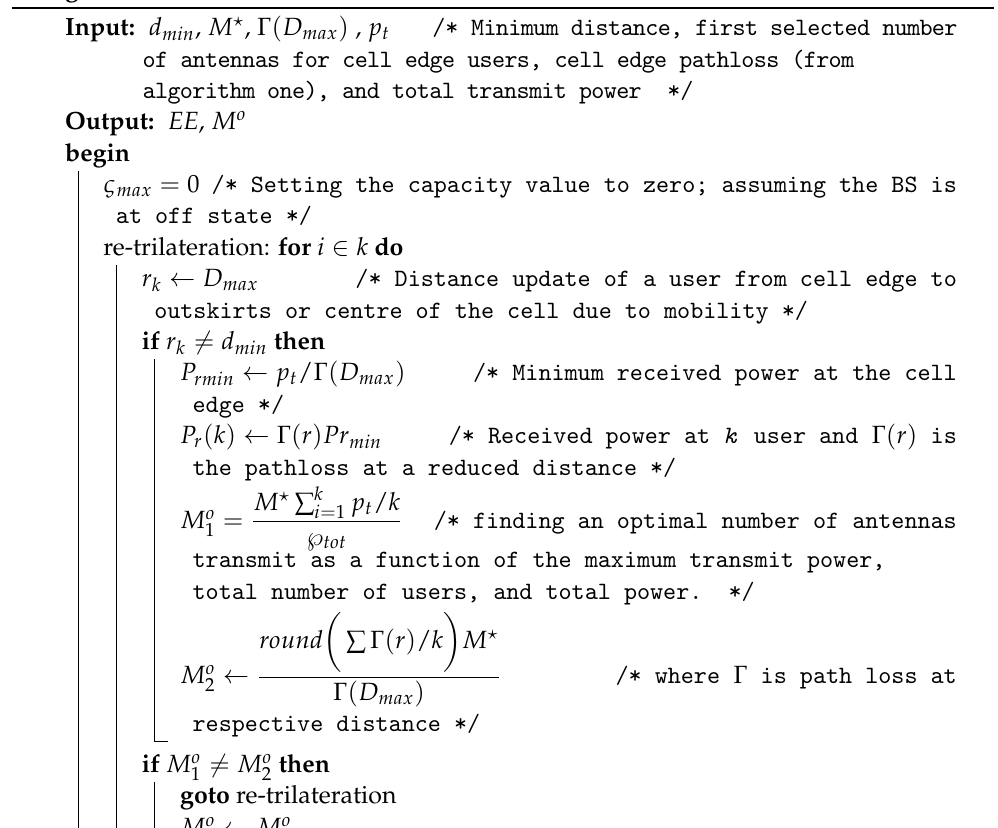
Algorithm 2: Number and element selection after reduced